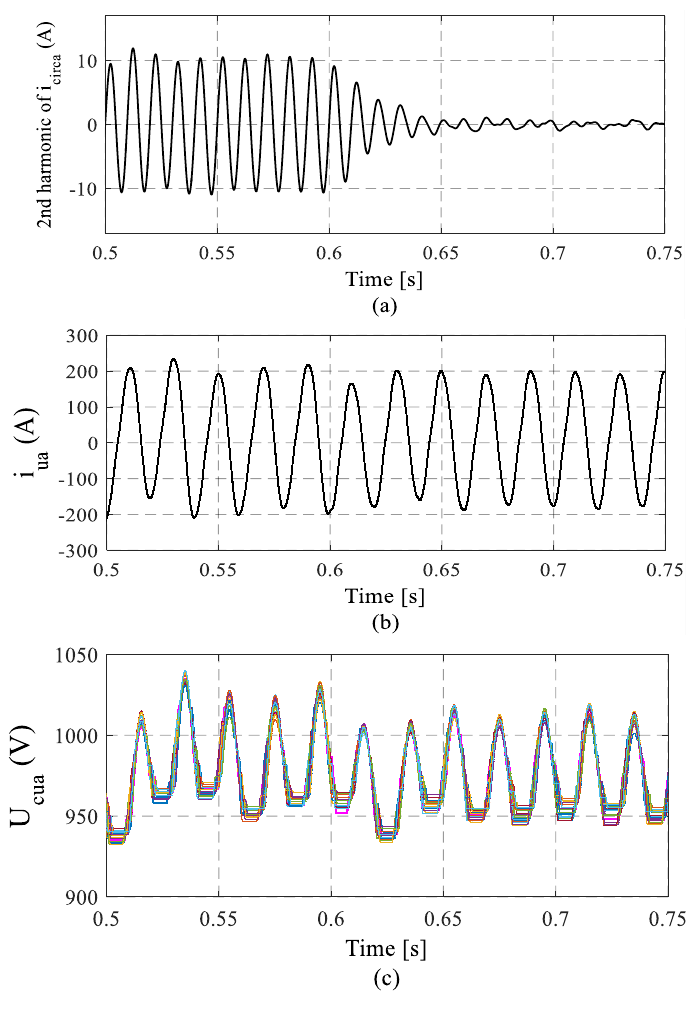
Figure 10. Simulated waveforms of the MMC using circulating current control: ( a ) Second harmonic component of the circulating current; ( b ) Upper arm current of phase-a; and ( c ) Upper arm SM capacitor voltages of phase-a.